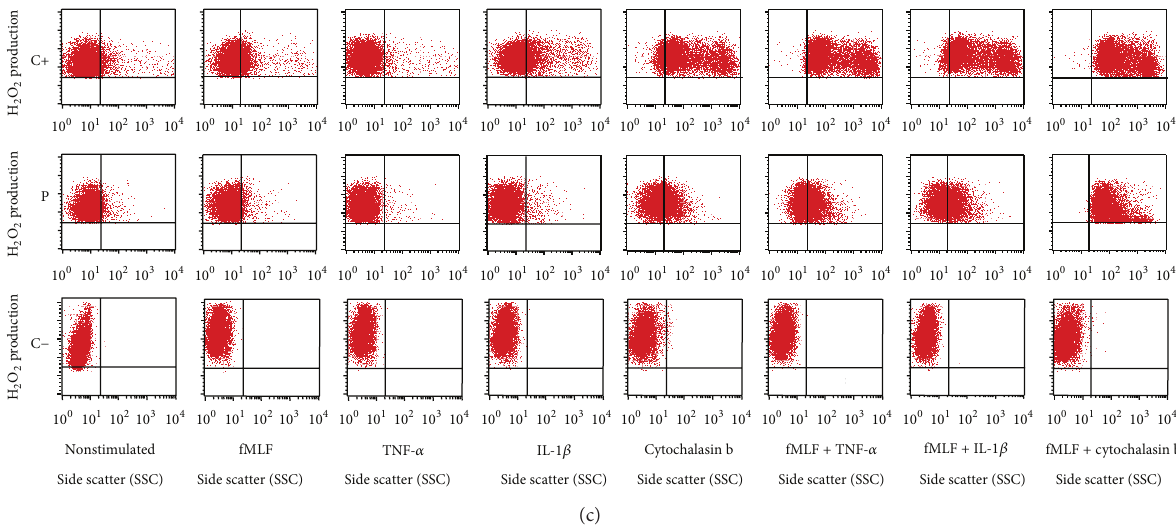
Figure 1: NADPH oxidase activity evaluation in PMNs. (a) Superoxide generation was measured by assaying superoxide dismutase- inhibitable cytochrome- c reduction in PNMs after adding three doses of PMA (4, 40, and 400 ng/mL), for healthy controls (C+), CGD patient (C − ), and our patient (P). (b) Histograms for the flow cytometric analysis of intracellular H 2 O 2 production, using the fluorescent 123DHR probe in PMNs from a healthy control (C+), an X-linked CGD patient (C − ), the proband (P), and the mother (H), before (NS) and after stimulation with PMA (4, 40, and 400 ng/mL). (c) PMNs from C+, C − , and P were left untreated or treated with TNF- 𝛼 , IL-1 𝛽 , and cytochalasin b and then stimulated with fMLF. The results shown are representative of two independent experiments.